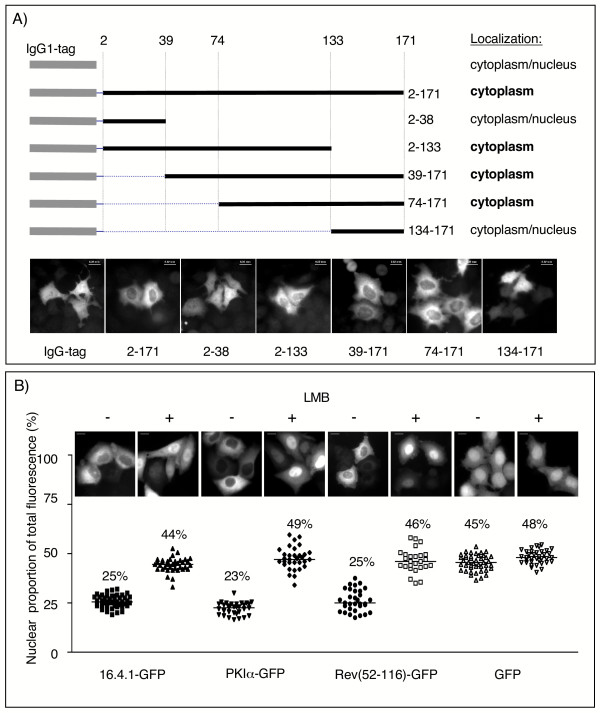
CRM1-dependent cytoplasmic localization of 16.4.1. HeLa cells were transfected with plasmids directing expression of IgG1-16.4.1 or 16.4.1-GFP fusion proteins and subcellular distribution of tagged proteins analysed 24 hours later in fixed cells. (A) Subcellular distribution of IgG1 fusion proteins containing full length 16.4.1 or various segments of 16.4.1. IgG1-16.4.1 proteins were detected by immunocytochemistry with a Cy3-conjugated anti human IgG1 antibody. A schematic diagram of the IgG1-16.4.1 fusion proteins and a summary of their localization behavior are shown at the top. Representative images of cells expressing IgG1 fusion proteins containing the indicated amino acid regions of 16.4.1 are shown below. IgG1 fusion proteins containing amino acids 2–171 (full-length), 2–133, 39–171 and 74–171 of 16.4.1 were predominantly cytoplasmic, whereas fusion proteins with amino acids 2–38 or 134–171 and unfused IgG1 were both cytoplasmic and nuclear. Scale bars: 20 μm. (B) Disruption of predominantly cytoplasmic localization of 16.4.1-GFP by treatment of cells with the CRM1-inhibitor Leptomycin B (LMB). HeLa cells were transiently transfected with plasmids for expression of 16.4.1-GFP, PKIα-GFP, Rev(52–116)-GFP and unfused GFP. Cells were treated with LMB (5 nM) for two hours. Representative images of the subcellular distribution of the GFP fusion proteins in untreated (-) and LMB treated cells (+) are shown at the top. Symbols in the graph indicate the nuclear proportion of fluorescence (%) in individual cells and horizontal lines and numbers the median of the cell population. LMB treatment increased the median nuclear proportion of 16.4.1-GFP from 25% to 44%. LMB had a similar effect on localization of GFP fusion proteins containing PKIα or the carboxyterminal region of Rev (aa 52–116), which are known transport substrates of CRM1. In contrast, LMB only marginally affects subcellular distribution of unfused GFP. Scale bars: 10 μm.